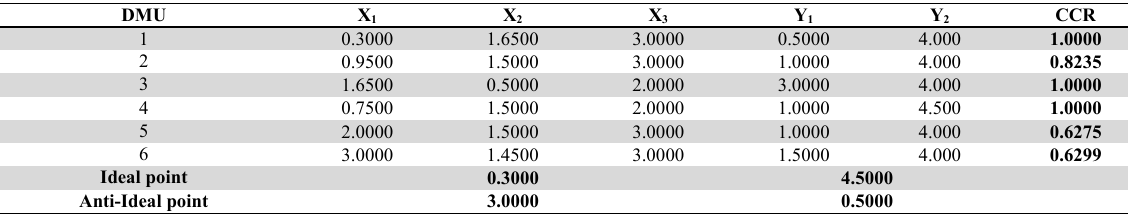
Ideal CEM of the methods of rice weevil